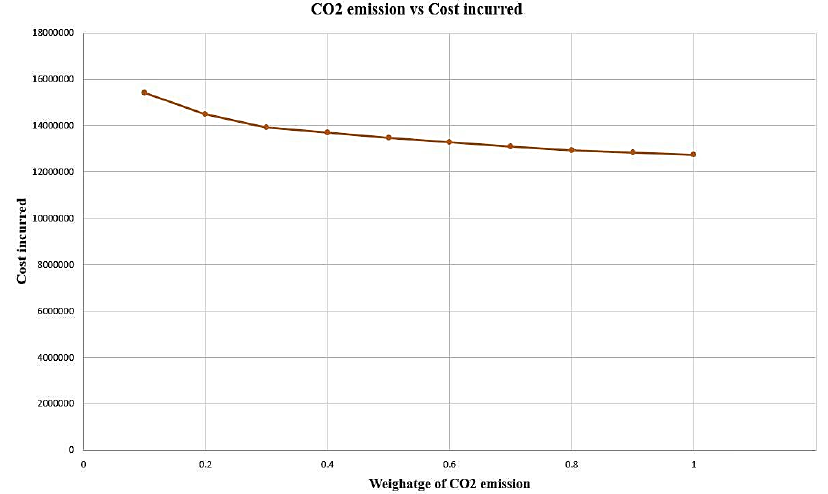
Fig. 4. CO2 emission vs. cost incurred graph.